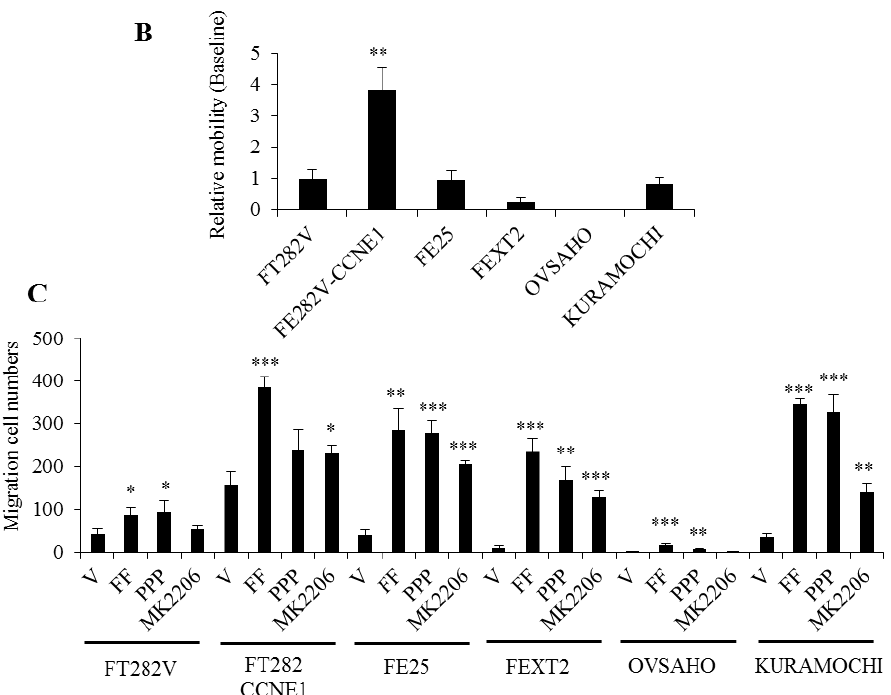
Figure 6. FF highly promotes the migration of FTE /HGSC cells, partially mediated by AKT. Under serum-free conditions, the transwell mobility assay was conducted using inserts with 8 µ m pores and cultured in DMEM with 10% FF or vehicle as a chemoattractant in two layers of medium. The same PPP and MK2206 pretreatment was done for 30 min and detected at 18 h. ( A ) Representative images of migrated cells of each treatment group. Scale bar, 100 µ m. ( B ) FT282-V cell line as a reference value to compare the baseline of cell motility. ( C ) The number of migrated cells per field were imaged and counted (mean ± SD; three independent experiments); * p < 0.05, ** p < 0.01, *** p < 0.001 by two-sided, unpaired Student’s t